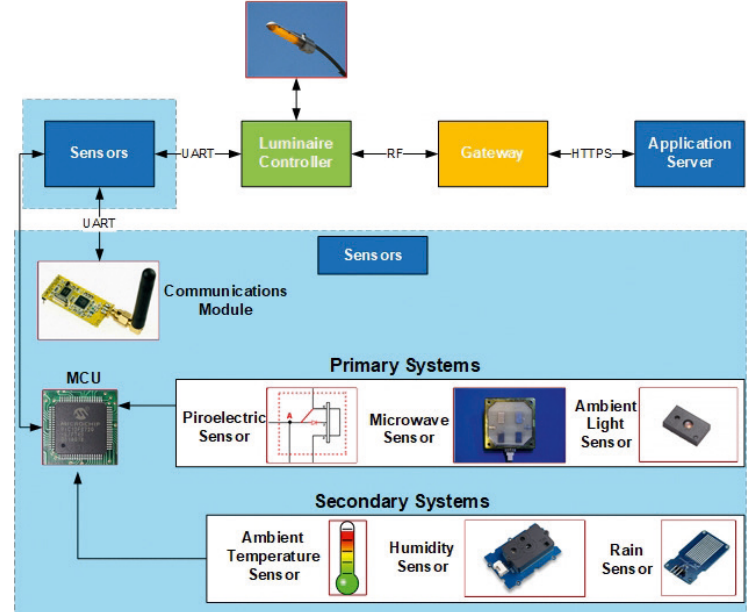
Figure 1. Primary element